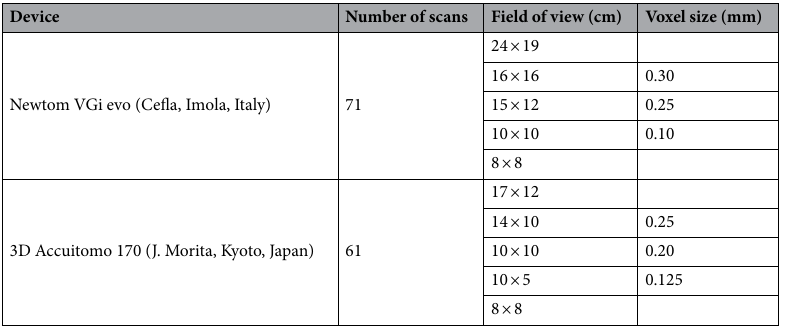
Table 1. CBCT scanning